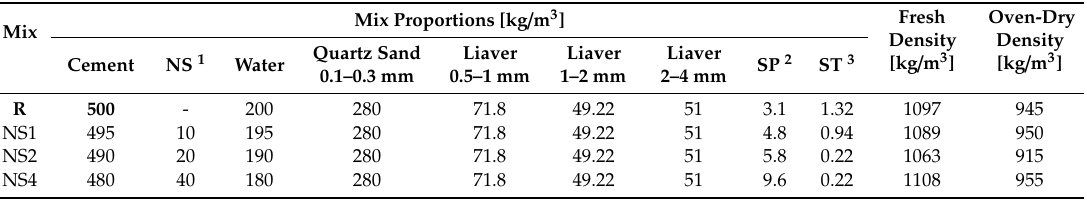
Table 3. Composition of lightweight concrete